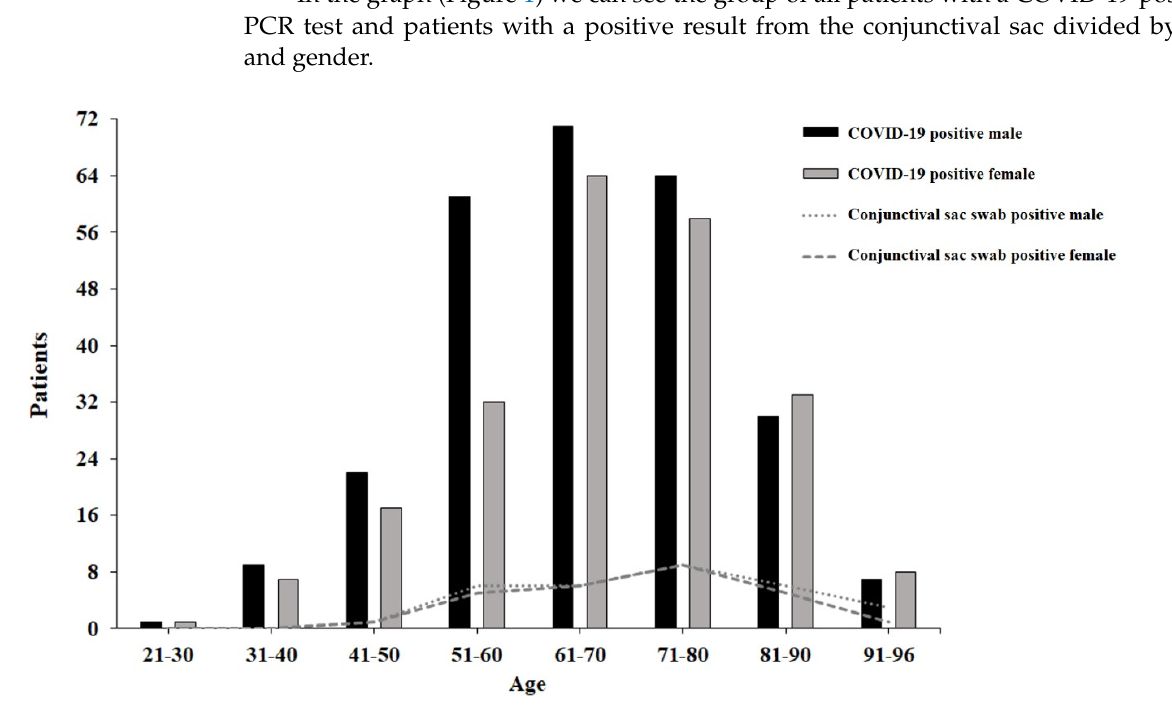
Figure 1. Patients in the group with COVID-19-positive PCR test and patients with positive result from the conjunctival sac divided by age and gender.